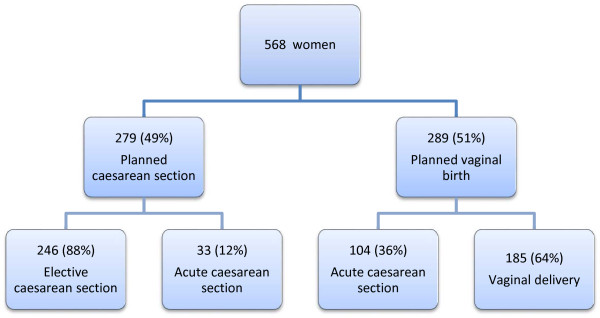
Study flow chart.